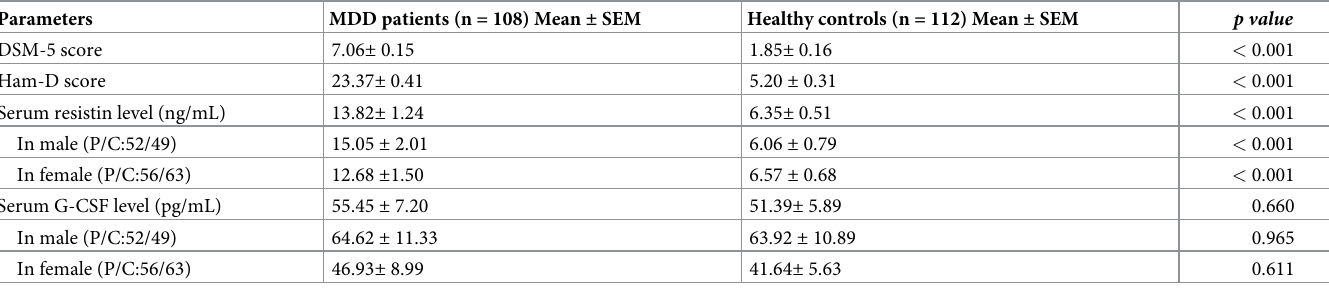
Table 2. Clinical information and laboratory findings of the study population.